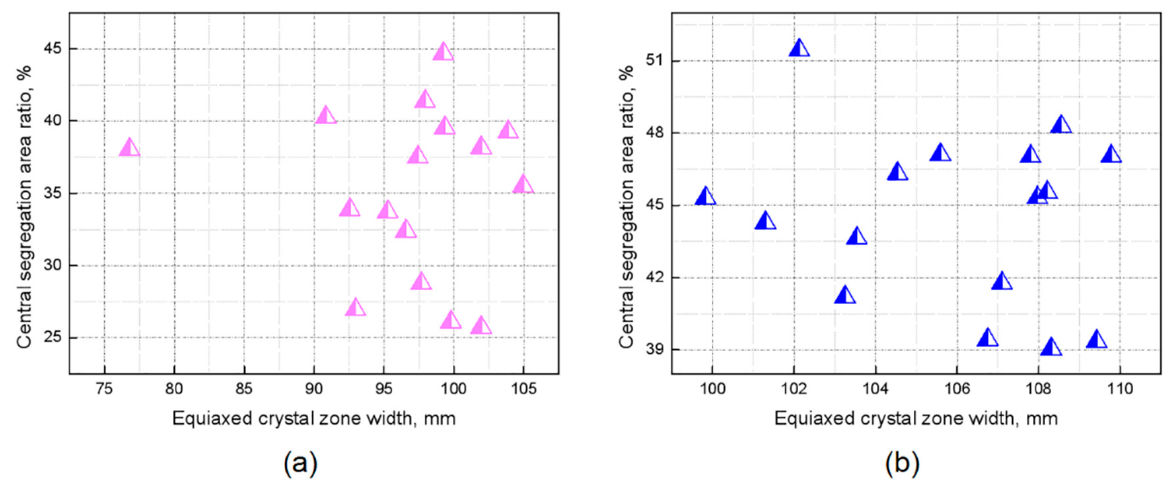
Figure 6. Distribution of the central segregation area ratio and the corresponding equiaxed crystal zone width of billet No. 1( a ) and No. 2 ( b ).